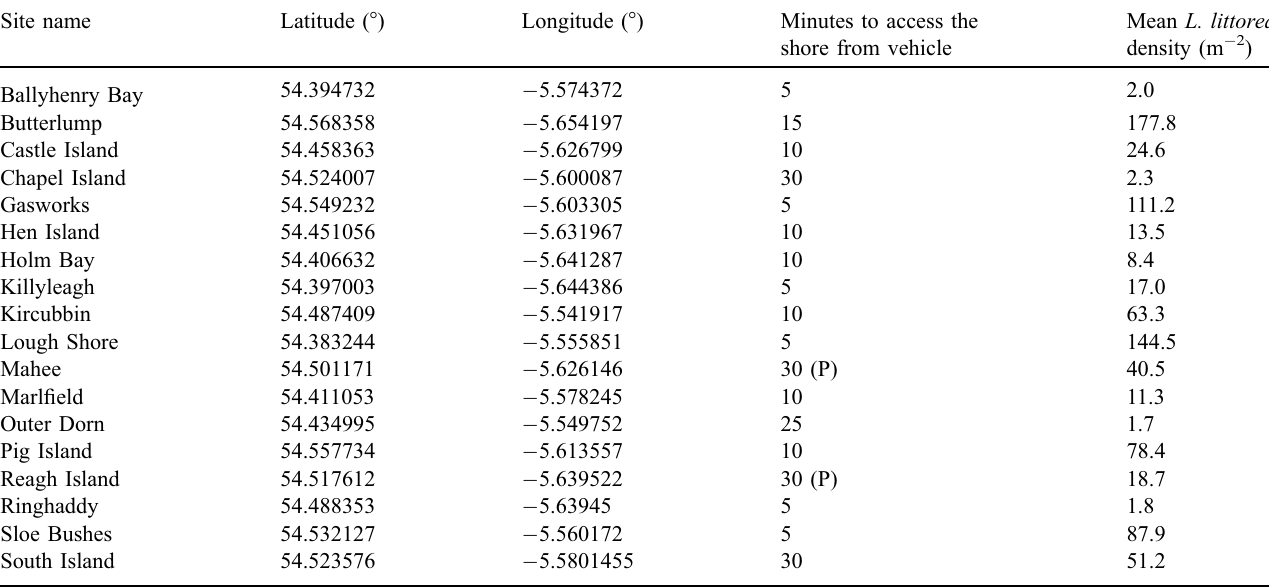
Table 1. Site locations in Strangford Lough, minutes to access the shore for potential harvesters and mean density of L. littorea pooling all surveys at a site. Sites with access across private land are indicated with “ P ”